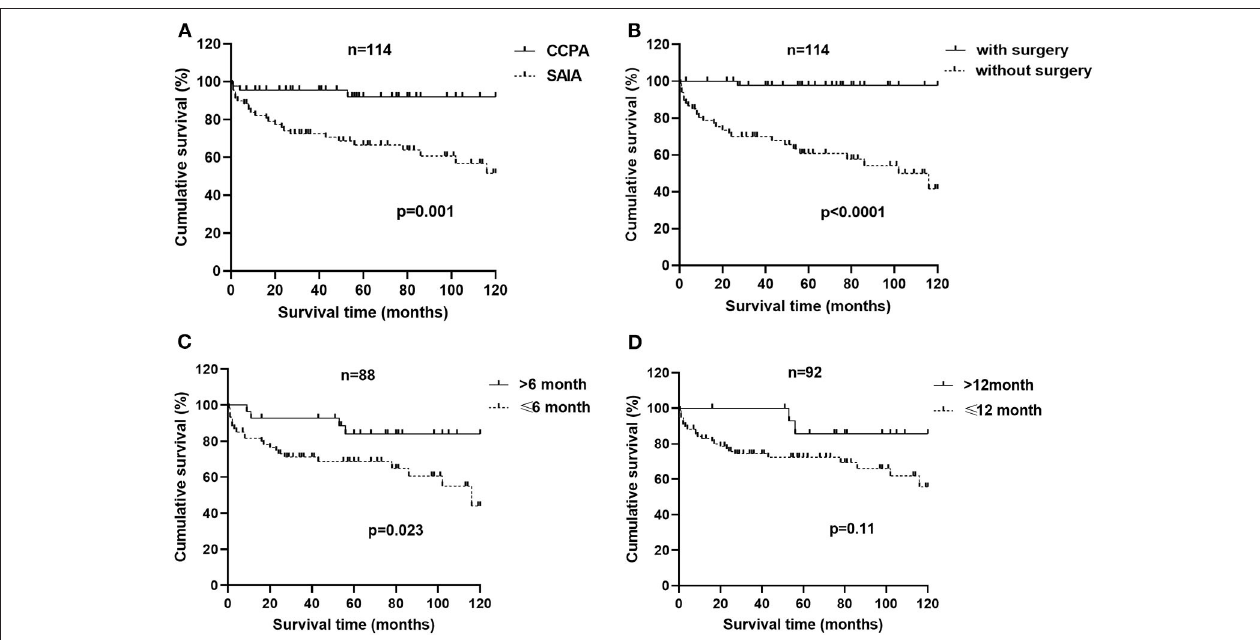
FIGURE 1 | Factors associated with a 10-year survival of patients with chronic cavitary pulmonary aspergillosis (CCPA) and subacute invasive aspergillosis (SAIA). (A) Survival from diagnosis to month 120 in patients of CCPA and SAIA groups according to Kaplan–Meier (K–M) analysis with log-rank test ( p = 0.001). (B) K–M cumulative survival curve of patients with chronic pulmonary aspergillosis (CPA) with and without surgical therapy with the log-rank test ( p < 0.0001). (C) K–M cumulative survival curve of patients with CPA who accept anti-fungal therapy for ≤ 6 months and > 6months with log-rank test ( p = 0.023). (D) K–M cumulative survival curve of patients with CPA who accept anti-fungal therapy for ≤ 12 months and > 12months with log-rank test ( p = 0.11).